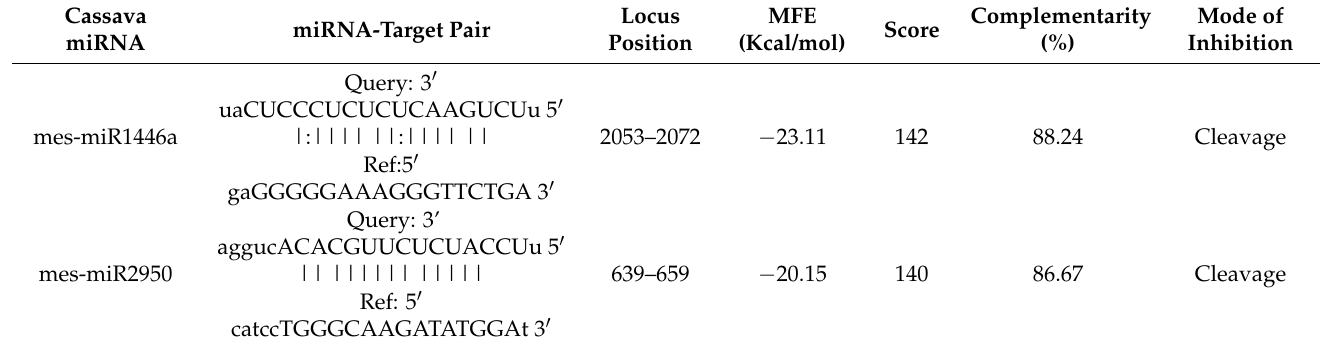
Table 5. Selected consensus cassava locus-derived mes-miRNA-target pairs predicted by at least three algorithms, with characteristic features of the miRanda and psRNA Target algorithms.